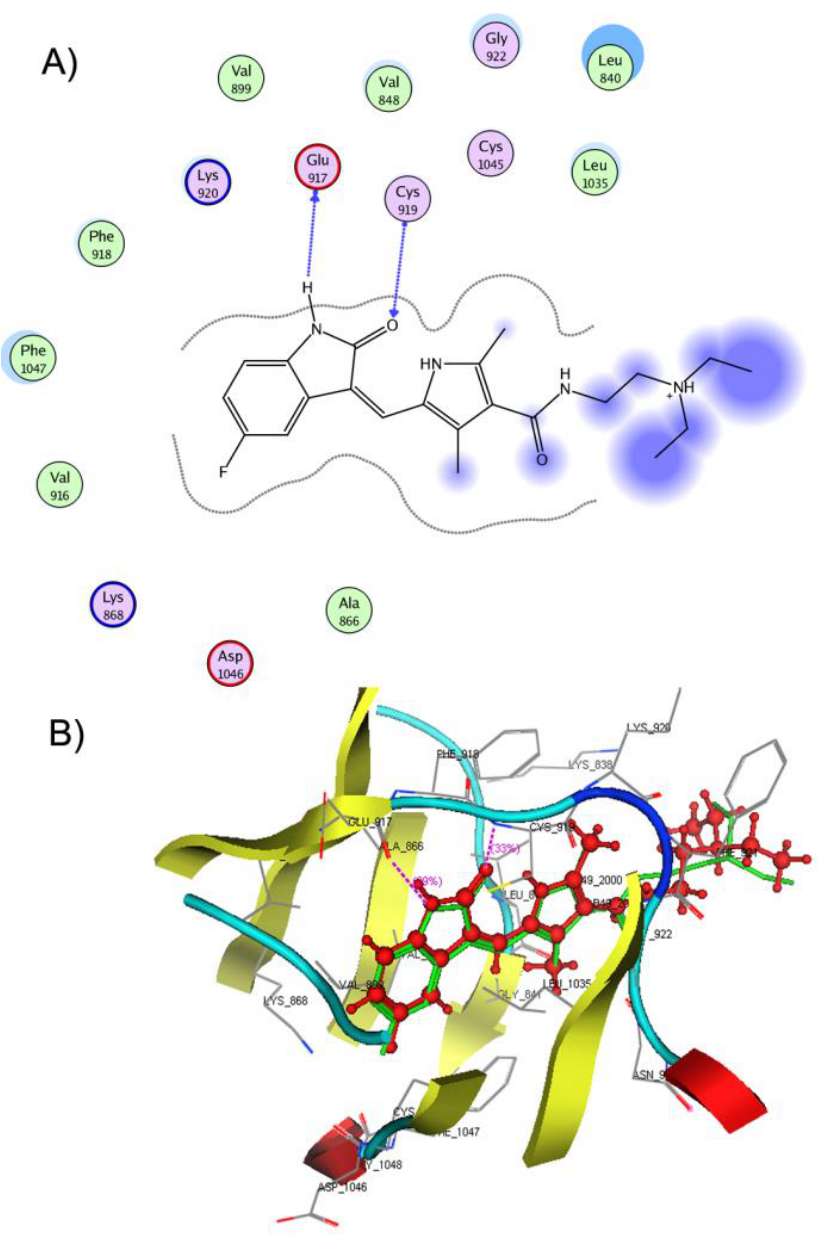
Figure 8. ( A ) 2D representation of the ligand interactions and ( B ) 3D representation of the re-docked sunitinib in the active site of VEGFR-2 (PDB ID: 4AGD). The native ligand is represented by green stick and the re-docked ligand is depicted as red ball and stick. Atom coloration (gray, carbon; blue, nitrogen; red, oxygen; yellow, sulfur; white, hydrogen; brown, bromine; green, fluorine).